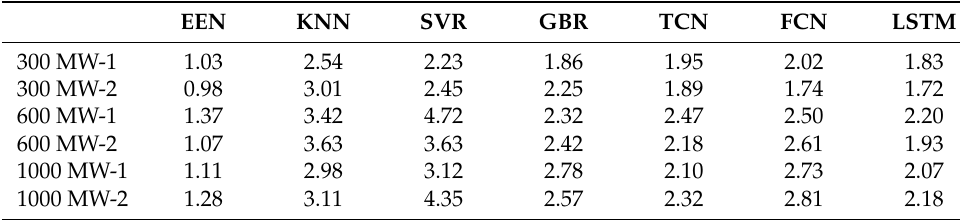
Table 2. MAPE of daily CO 2 emissions.